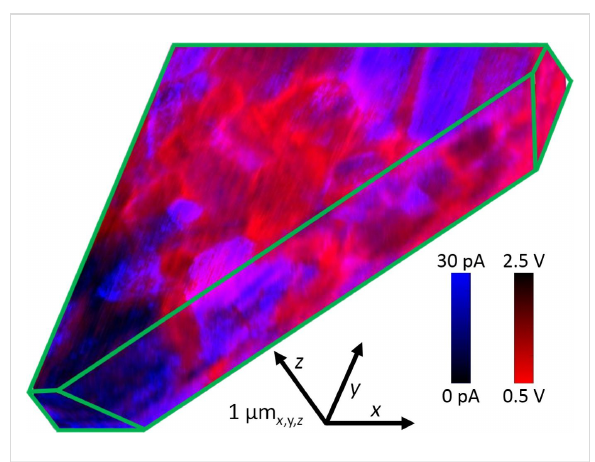
Figure 4: Three-dimensional CT-AFM of the short-circuit current ( I SC *, dark to blue contrast) merged with the directly measured open-circuit voltage ( V OC *, red to dark) volumetrically rendered to partially reveal an xy plane, xz and yz cross sections, and an oblique xyz cut to uniquely expose the nanoscale properties through the specimen thick- ness. The identified axes also serve as scale